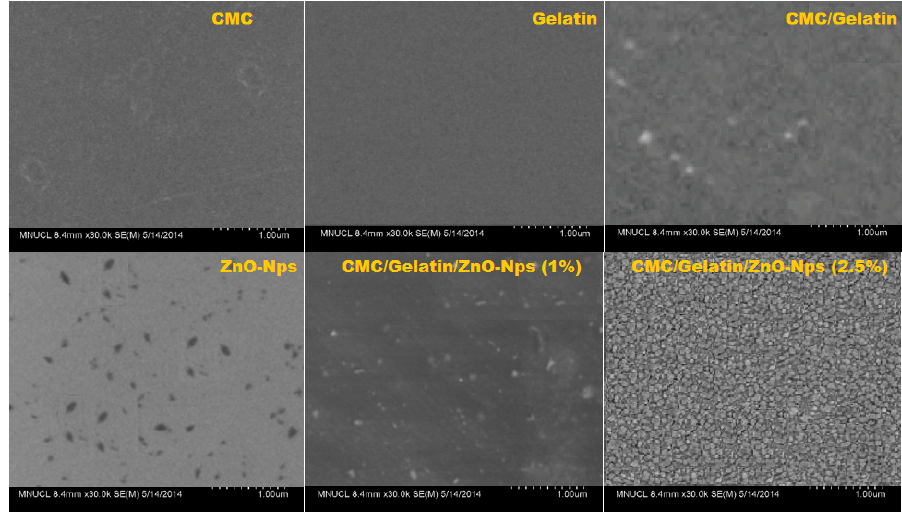
Figure 3. Scanning microscopy images of neat CMC, gelatin, CMC/gletan and CMC/gelatin/ZnO-Nps.